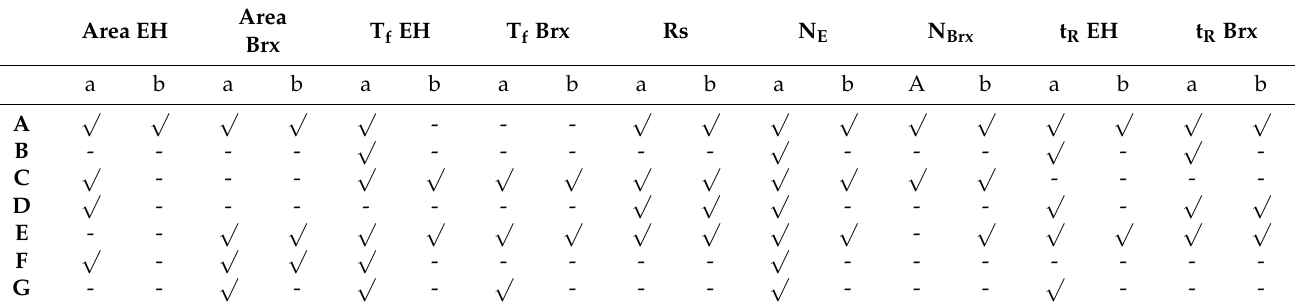
√ Table 8. Summarization of significant ( ) and non-significant (-) effect of the factors A-G on each response, after (a) statistical and (b) graphical interpretation of the estimated